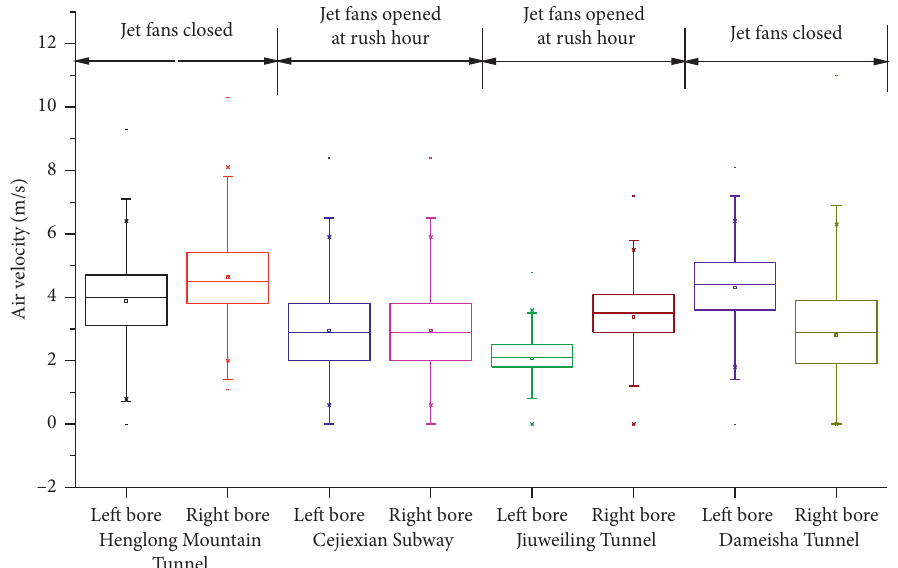
Figure 8: The statistics results of air velocity in the four urban tunnels.